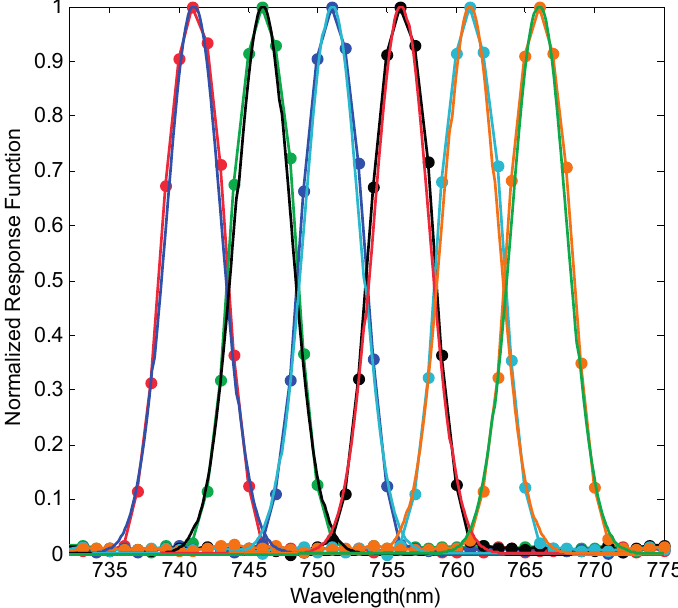
Figure 10. The SRFs obtained with a simulated scanning monochromator. The curves with spots are the normalized simulated DN value, and the other curves are the fitted results.